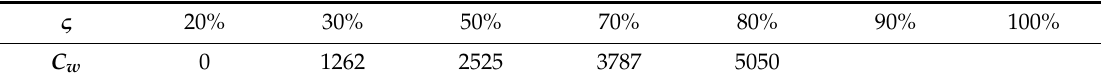
Table 2. List of experimental conditions.